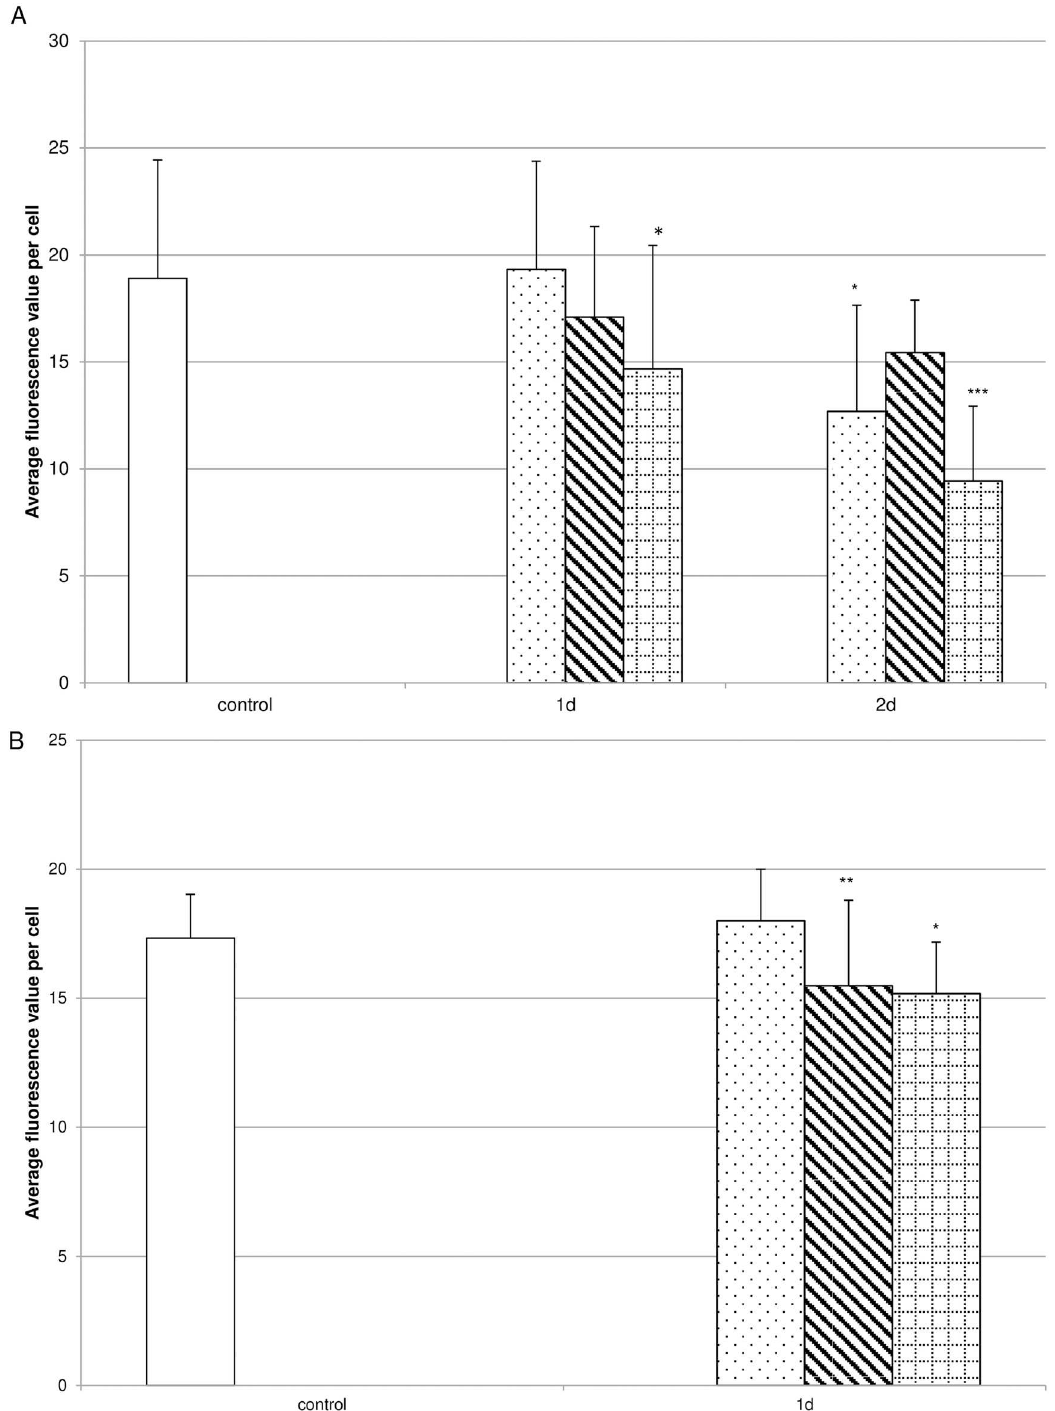
Fig 7. Biodentine ® suspensions decreasedthe collagen type I and TGF- β 1 concentration. Collagentype I (A) and TGF- β 1 (B) concentrations were measuredby quantifyingthe fluorescence intensities of the respective immunhistochemicalstainings of cultures treated with Biodentine ® suspensionsof low (dotted bar), moderate (striped bar) or high (brickedbar) Biodentine ® concentrations in comparisonto control cultures (white bar). The data displayedare representative of two independentexperiments performed with comparable results. Average fluorescence intensity per cell (mean ± SD) from 14 to 17 individualcells per experimental conditionwere calculated. * p (cid:20) 0.05; *** p (cid:20) 0.001.